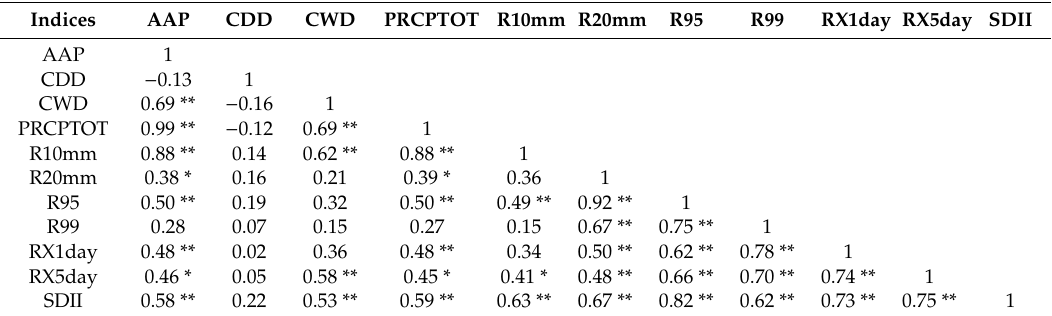
Table A2. Correlation coe ffi cients between annual average precipitation (AAP) and the extreme precipitation indices in alpine steppe.